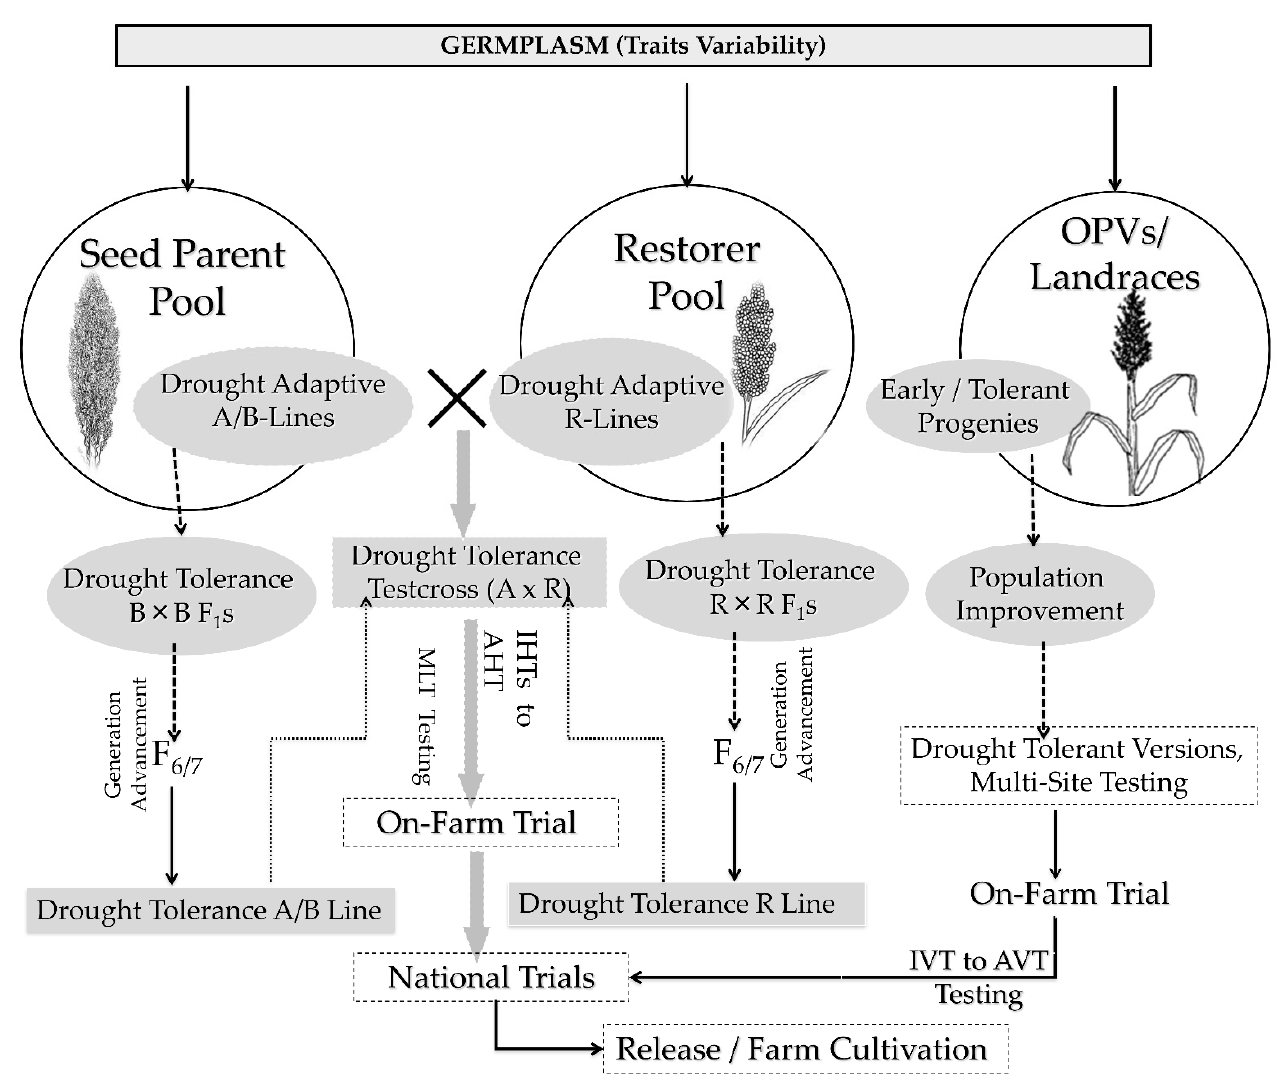
Figure 3. Fast-track breeding approaches for developing variety and hybrids for drought tolerance in sorghum. Briefly, genetic variation for drought tolerance in sorghum is sourced from elite breeding populations or germplasm. In sorghum, development of hybrid requires a male sterile line (A-line), a maintainer line (B-line), and a restorer line (R-line). A-line is male sterile and used as female; B-line is an isogenetic line of A-line and serves as maintainer line, and R-line is a male fertile line used as pollen parent. Identified tolerant lines will be crossed within gene pool (B-lines/R-lines) of sorghum (without interrupt maintainer or restoration genes) to produce recombinants to select and fix in subsequent generations (i.e., F2–F7). At ≥ F7 stage, crosses between two gene pool rewards the hybrids population to test in target sites to release a candidate hybrid with tolerance and on parallel, respective B-lines to be converted to its male sterile version (A-line) for commercial production. Various test crosses between A and R lines go through testing at initial hybrid trials (IHTs) to advanced hybrid trials (AHTs) in on-farm tests, whereas in open pollinated varieties (OPVs) breeding, the selected intra-population progenies crosses were recommended to be released as a final product after sequential testing at multiple locations under initial variety trials (IVT) and advanced variety trials (AVT).